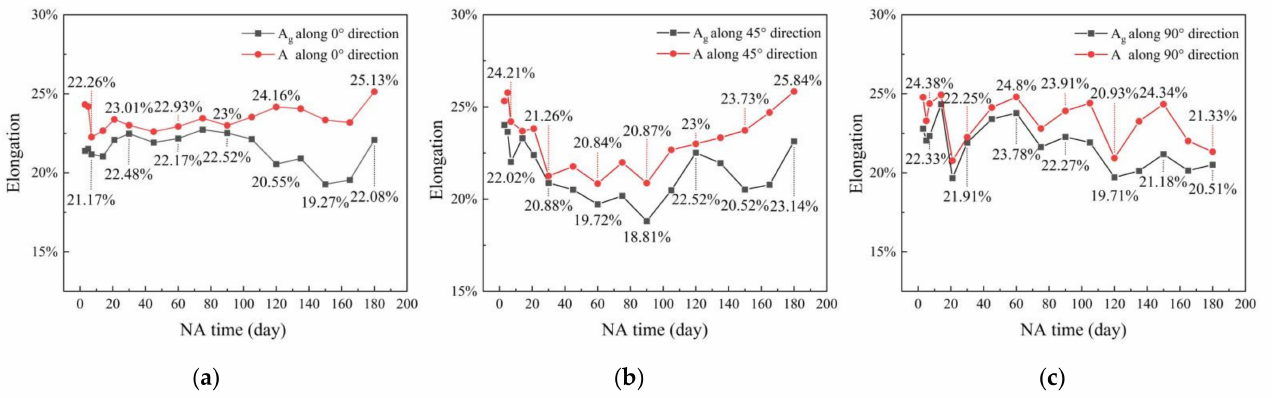
Figure 8. The change curves of A g and A along 0 ◦ ( a ), 45 ◦ ( b ), and 90 ◦ ( c ) directions during six months of